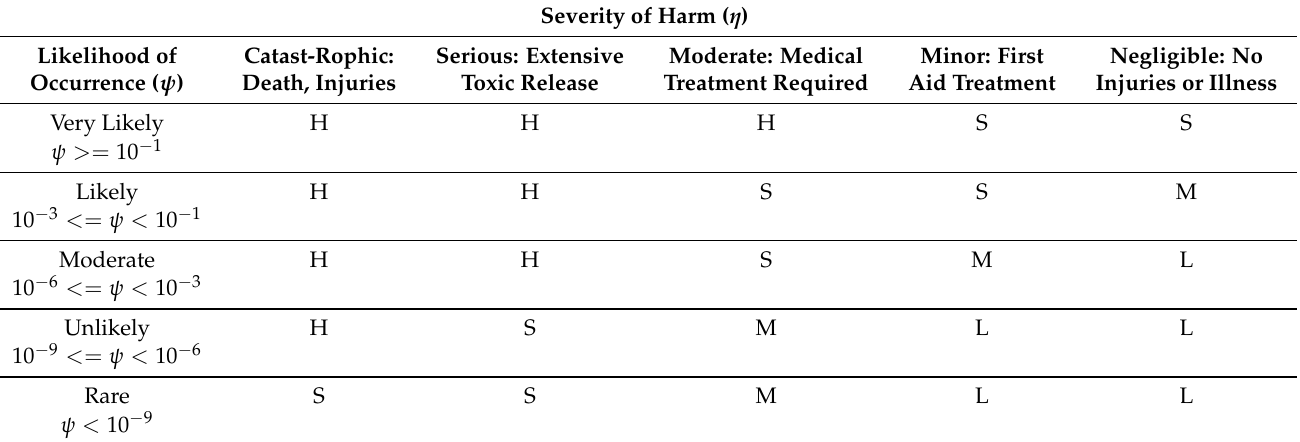
Table 1. Risk Level Classification.